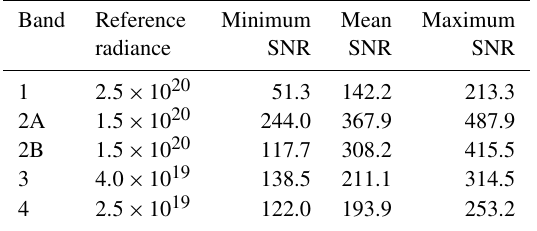
Table 6. Radiometric performance of the GHOST spectrom- eter, as determined from the calibration measurements de- scribed in Sect. 3.5. The reference radiances are in units of photonss − 1 m − 2 µm − 1 sr − 1 and are typical of the spectral radiance levels observed during the Global Hawk flights (e.g. see Fig.